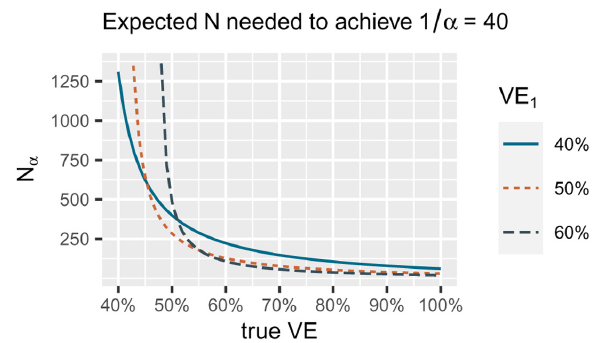
Figure 2. N is the expected number of events needed to reach α a betting score of 1/ α = 40 for α = 0.025 if we bet according to VE indicated by the three different lines, with bets each of 1 |( )VE 1 the form 1